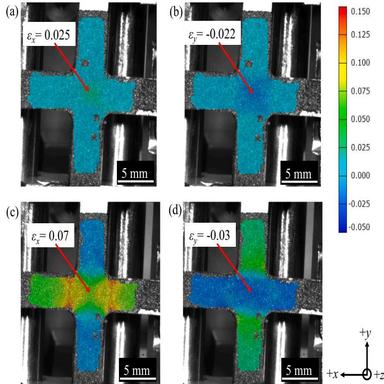
Experimental macro-strain in AA5182-O specimen during continuous strain path change: (a) εx and (b) εy strain distribution along uniaxial strain path before the strain path transition and (c) εx and (d) εy strain distribution after the strain path transition to biaxial strain path.